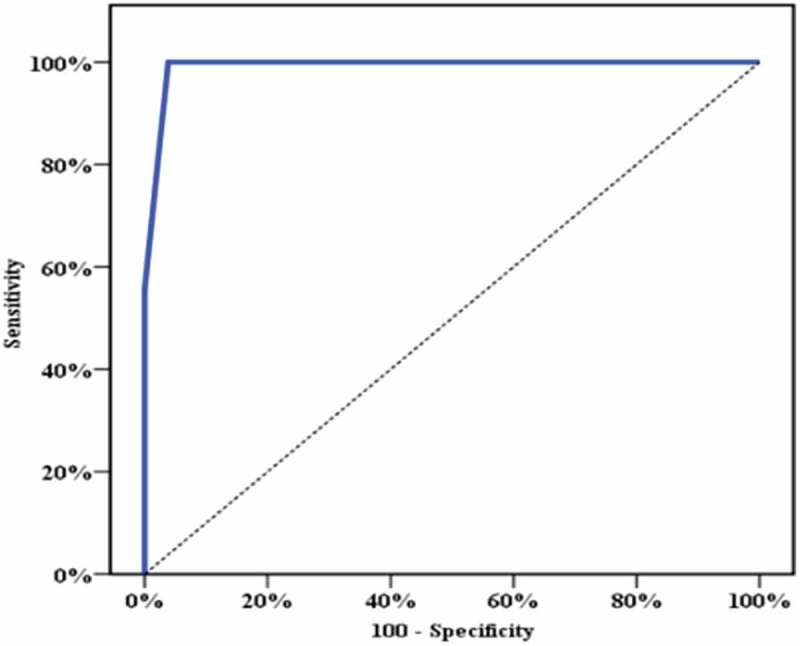
ROC curve for height resistance to diagnose PVR >50 mL.